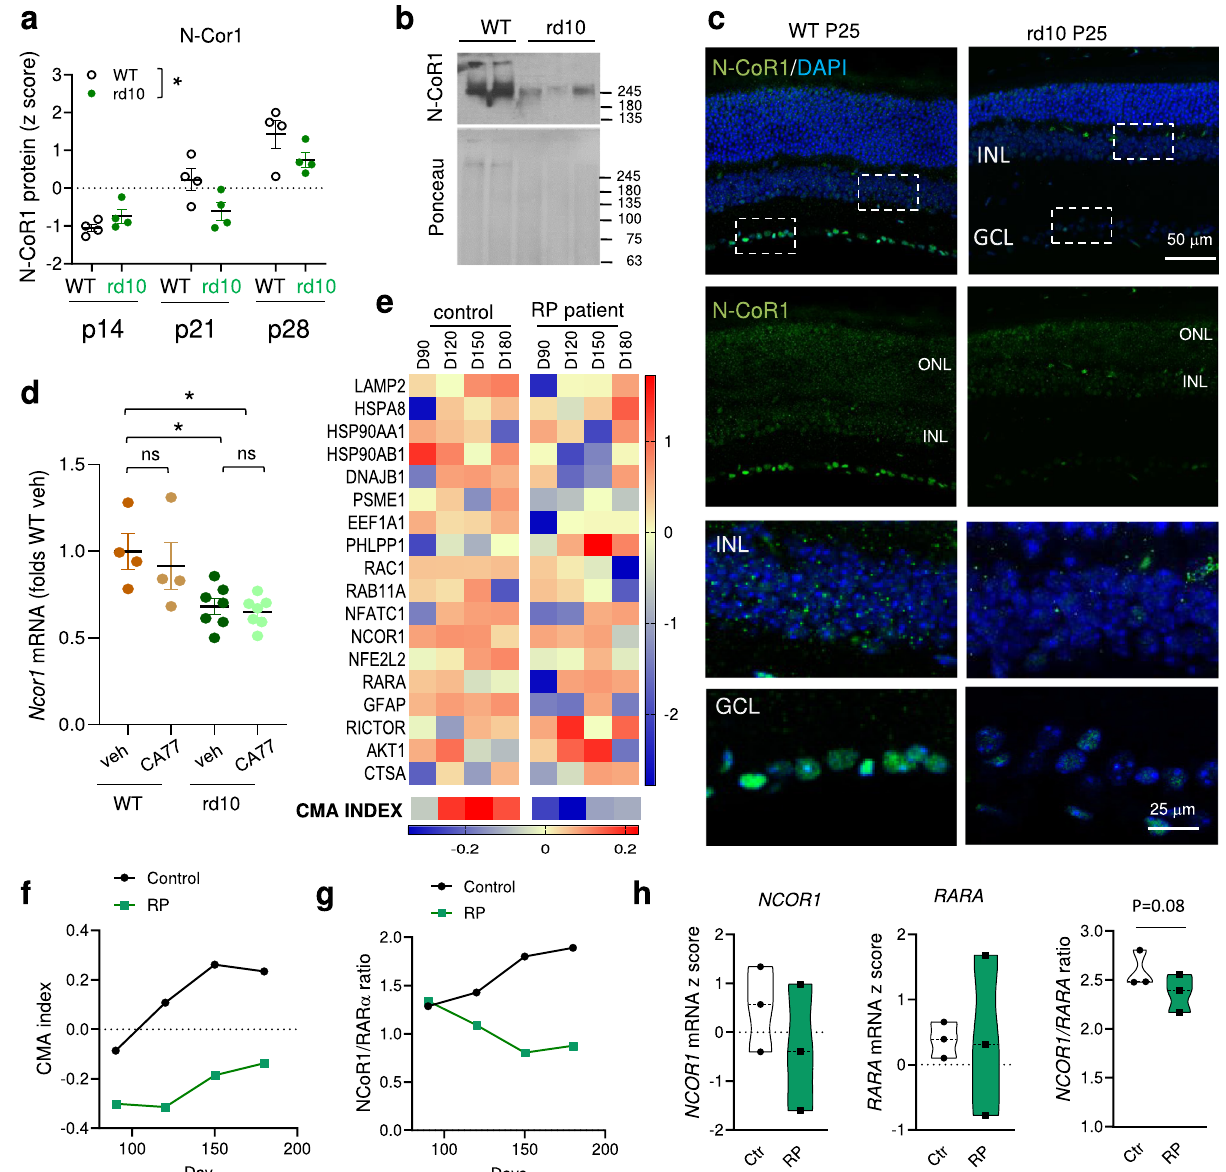
Fig. 8 N-CoR1 expression is reduced in retinitis pigmentosa . a Protein levels of N-CoR1 in retinas from wild type (WT) and rd10 mice at the indicated postnatal (P) days. Data from 23 . Values are expressed as Z score. n = 4 mice/genotype/time. b Immunoblot for N-CoR1 in retinas of 2 WT and 3 rd10 mice. Ponceau staining is shown as loading control. c Immunostaining for N-CoR1 in cyrosections of WT and rd10 mice retinas at p25. Nuclei are highlighted with DAPI. Merged (DAPI and N-CoR1) (top) and single (N-CoR1) (bottom) images. Bottom: Higher magni fi cation of boxed regions from the inner nuclear layer (INL) (top) and in the ganglion cell layer (GCL) (bottom). d Ncor1 mRNA levels in WT and rd10 mice treated from P18 to P25 with daily i.p. injection of vehicle or CA77 (40 mg/kg bw). Values are expressed as folds WT vehicle. n = 4 (WT) and 7 (rd10) mice. e Heat map of CMA network genes expression in retinal organoids from healthy (Control) and retinitis pigmentosa patients (RP) bearing the PDE6B mutation. D: days of organoid differentiation. D90-D180: features of mid-state disease; D230: features of late-state disease. CMA index 14 is shown at the bottom. Data from 24 . f , g CMA activation index ( f ) and ratio of NCOR1 to RARA mRNA levels ( g ) in the same samples as in e . RNA was isolated from 3-5 organoids from two independent differentiations. h mRNA levels of NCOR1 (left), RARA (middle) and NCOR1 to RARA ratio in retinal organoids from Control and RP patients bearing mutations in RP2 at D180. Data from 25 n = 3 individuals per diagnosis (minima, maxima, center, bounds of box, whiskers and percentile, are detailed in the Source Data File). Individual values and mean + s.e.m. are shown. Two-way ANOVA was used in a, One-way ANOVA with Tukey ’ s multiple comparison post-hoc test in d and two-sided paired t test in h. * p < 0.05 and ** p < 0.01. ns, not signi fi cant. Uncropped blots are in Supplementary Fig. 10. Source data and exact p values are provided as a Source Data fi